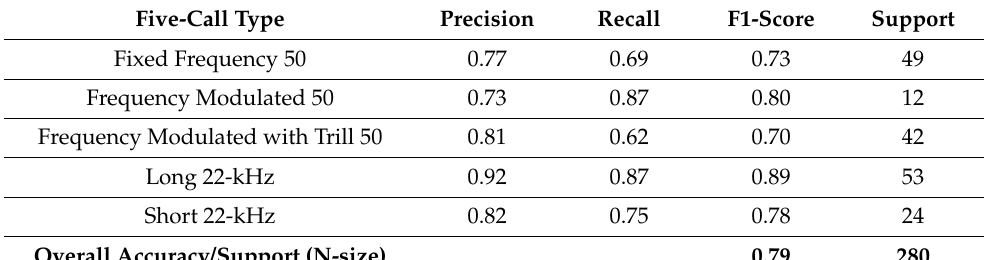
Table 4. Evaluation of the five-call composite classification model performance on the test